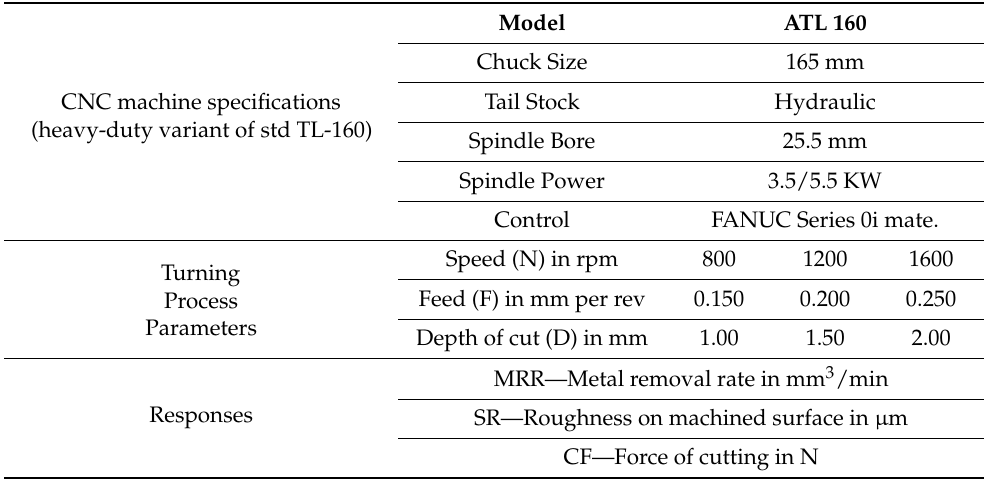
Figure 2. CNC machine used for the experimental investigation. Table 1. CNC machine specifications with parameter for turning process and responses for the ex- periment.